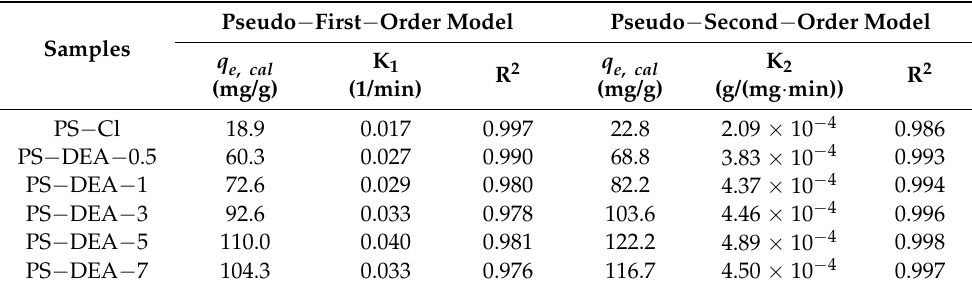
Table 5. Adsorption kinetic parameters of pseudo − first − order and pseudo − second − order model